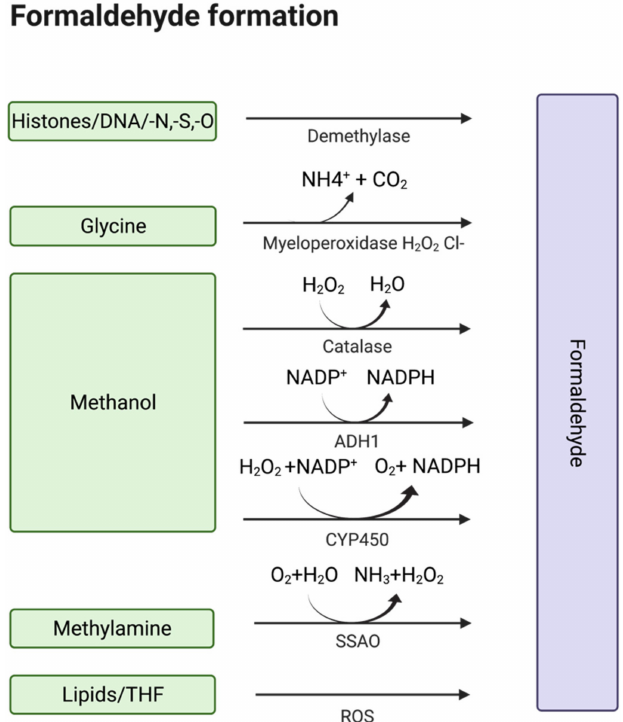
Figure 1. Sources of endogenous FA. Created with